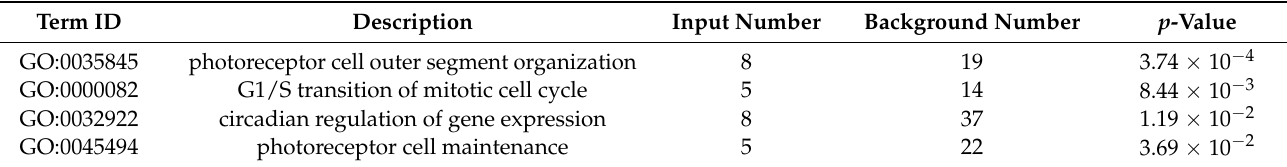
Table 3. The most important biological processes inhibited at non-spawning temperature.